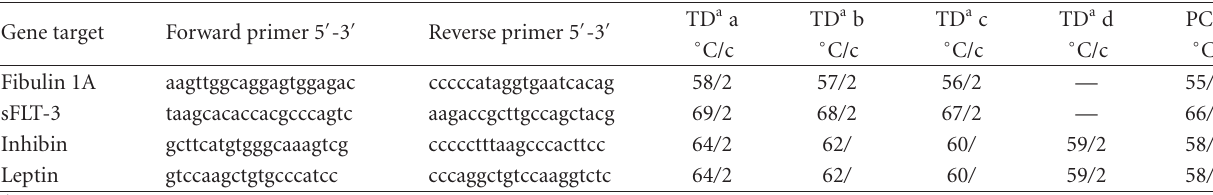
Table 2: Primers and PCR conditions.